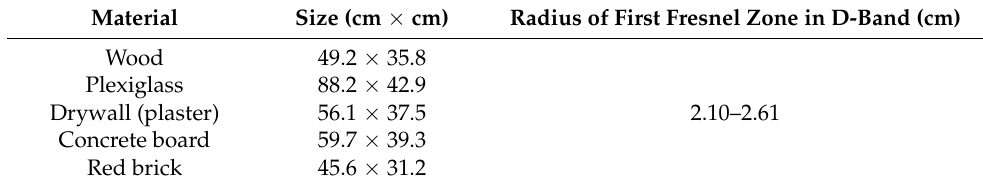
Figure 5. ( a ) The indoor reflection measurement campaigns in D-band for five materials, ( b ) Wood, ( c ) Plexiglass, ( d ) Drywall (plaster), ( e ) Concrete board, ( f ) Red brick. Table 5. Size of Materials and First Fresnel